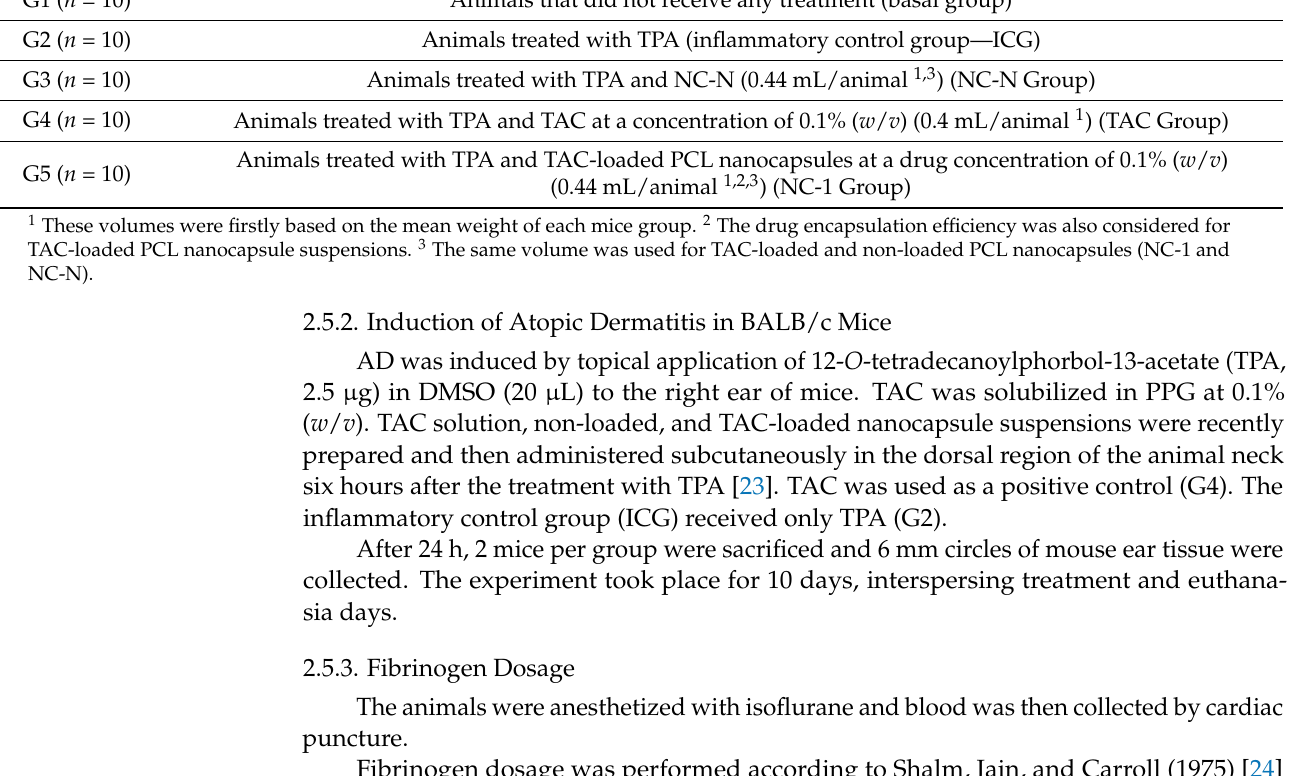
Table 1. Group treatment scheme.